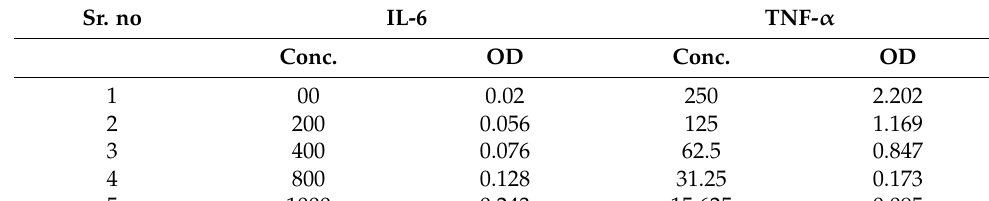
Table 6. IL-6 and TNF- α result of co-combination gel (E+D). Sr. no